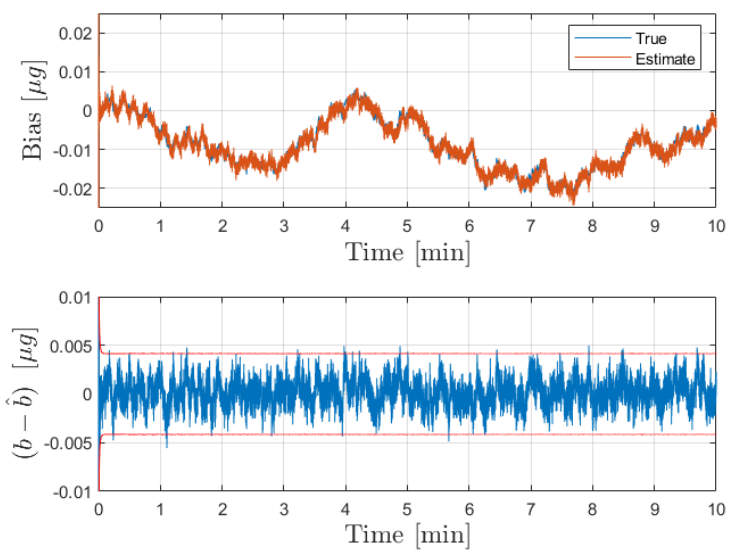
Figure 2. Results for the bias estimate obtained from the simulated calibration phase. The top figure shows the true and estimated bias over the calibration time interval of 10 min. On the bottom, the error in the bias estimate is plotted in blue with the corresponding 3 σ bounds in